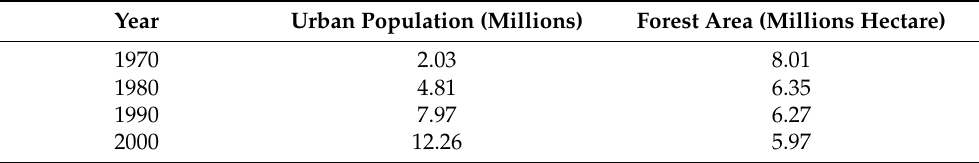
Table 14. Decadal urban population and forest area in Peninsula Malaysia